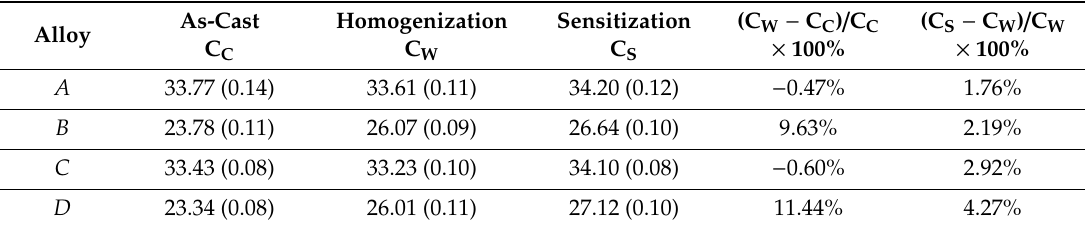
Table 3. Electrical conductivity of experimental alloys in di ff erent conditions.